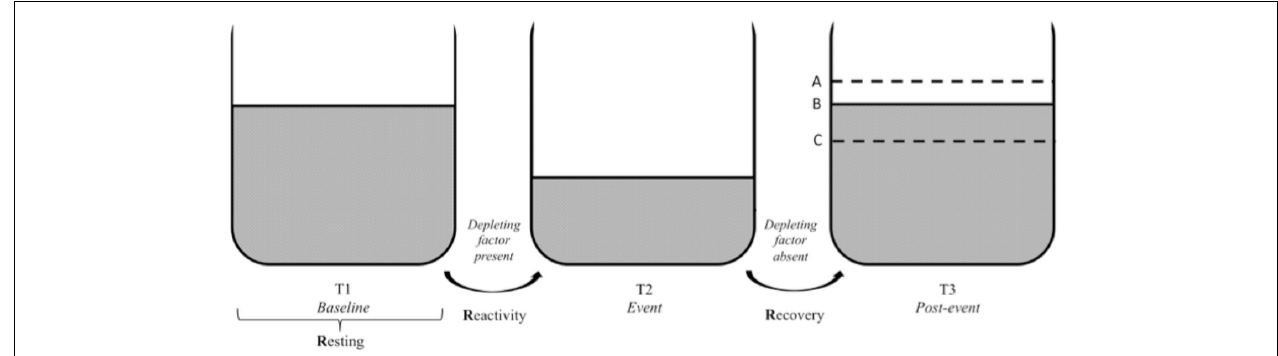
FIGURE 3 | Vagal tank and the 3 Rs of cardiac vagal control: effect of a depleting factor. Illustration of the vagal tank and the three Rs (resting, reactivity, and recovery) with a factor depleting cardiac vagal control. In regards to the post-event: A – displays a situation where the level of carrdiac vagal control during the post-event is higher than the initial level at baseline, B – displays a situation where the level of cardiac vagal control at post-event is similar to the initial level at baseline, and C – displays a situation where the level of cardiac vagal control at post-event did not recover to the point of its initial baseline level.